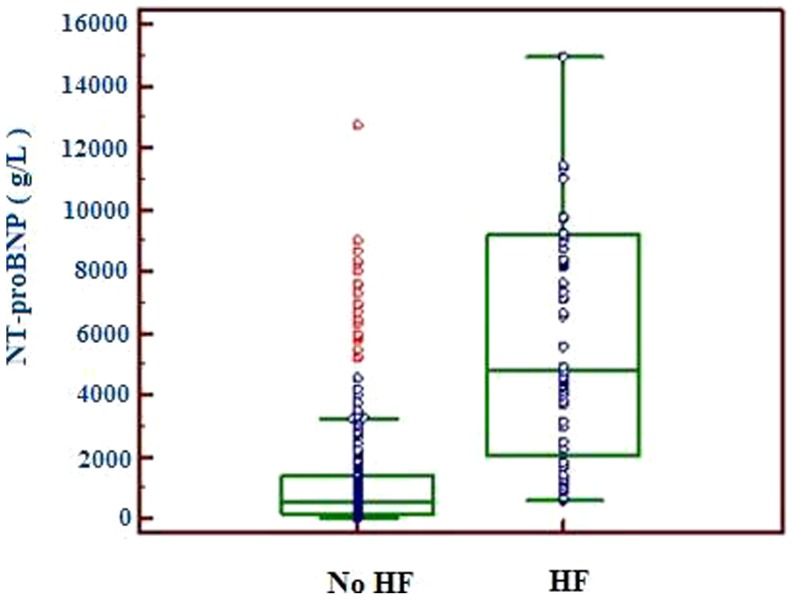
Box plot of plasma NT-proBNP concentrations in AECB patients with or without LV failure.Horizontal lines in the box indicate 25th, 50th and 75th percentiles, and I bars represent highest and lowest values. NT-proBNP: N-terminal pro-B type natriuretic peptide; AECB: acute exacerbation of chronic bronchitis; LV: left ventricular.